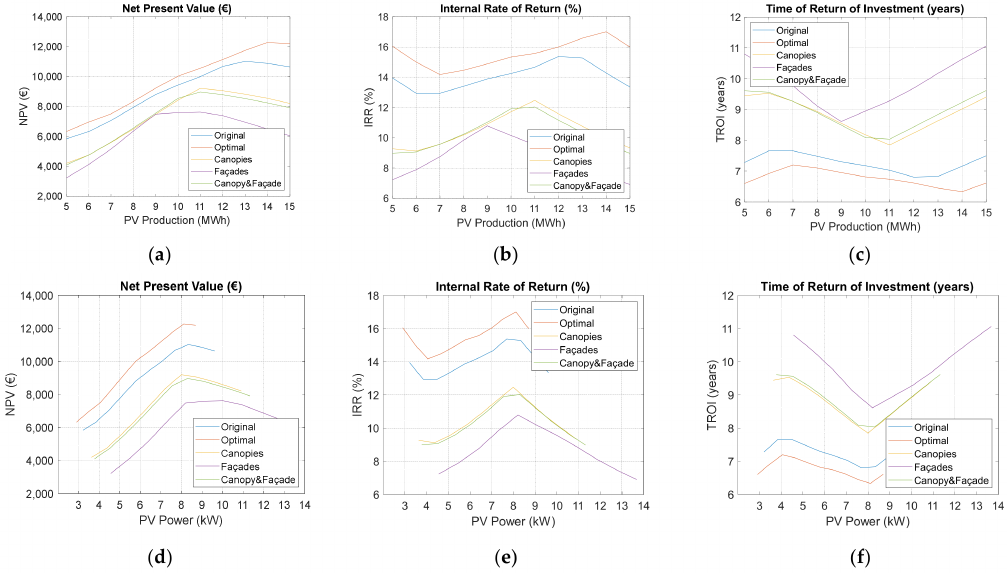
Figure 9. Economic balance. ( a ) Net present value vs. annual PV production; ( b ) internal rate of return vs. annual PV production; ( c ) time of return of investment vs. PV annual PV production; ( d ) net present value vs. PV installed power; ( e ) internal rate of return vs. PV installed power; ( f ) time of return of investment vs. PV installed